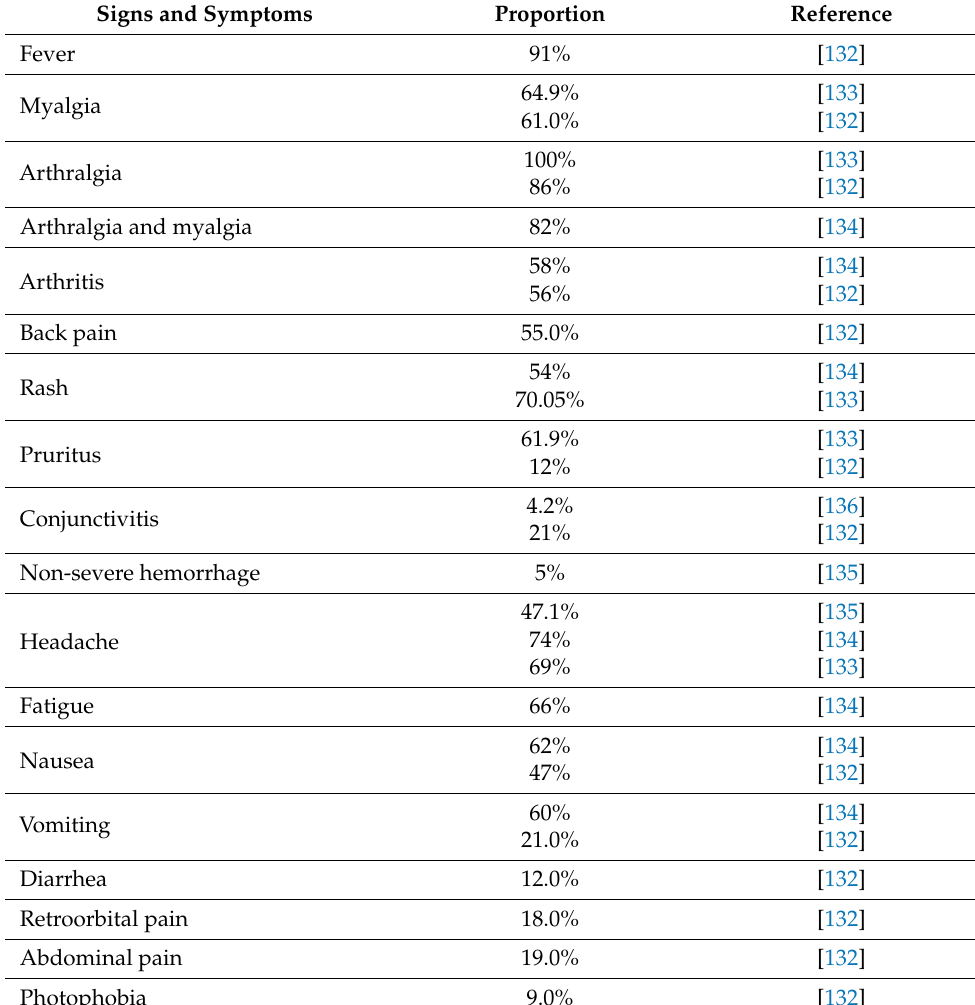
Table 1. The clinical manifestation of chikungunya